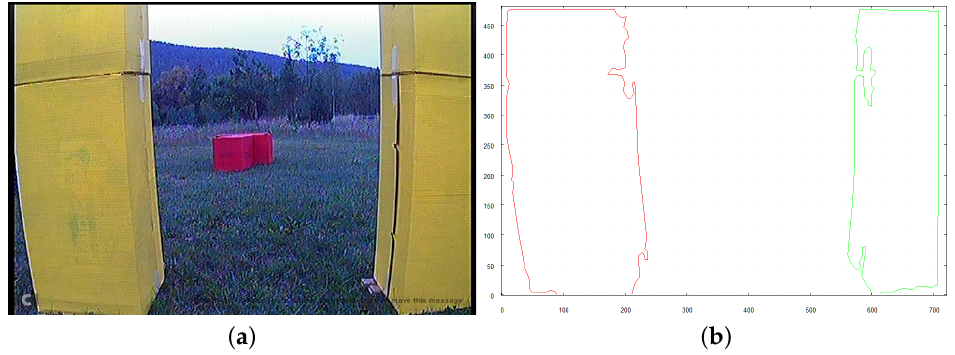
Figure 33. Robot approaching structure to fly underneath, 3.0 s after starting from initial position. ( a ) image from robot’s camera ( b ) vectorized image from